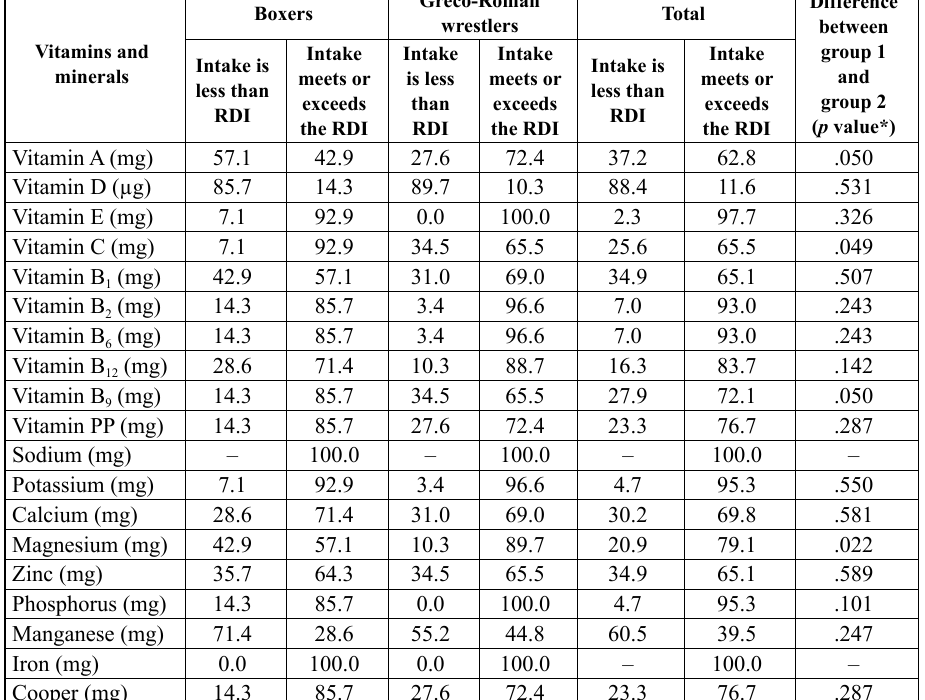
Note. RDI – recommended daily intake.